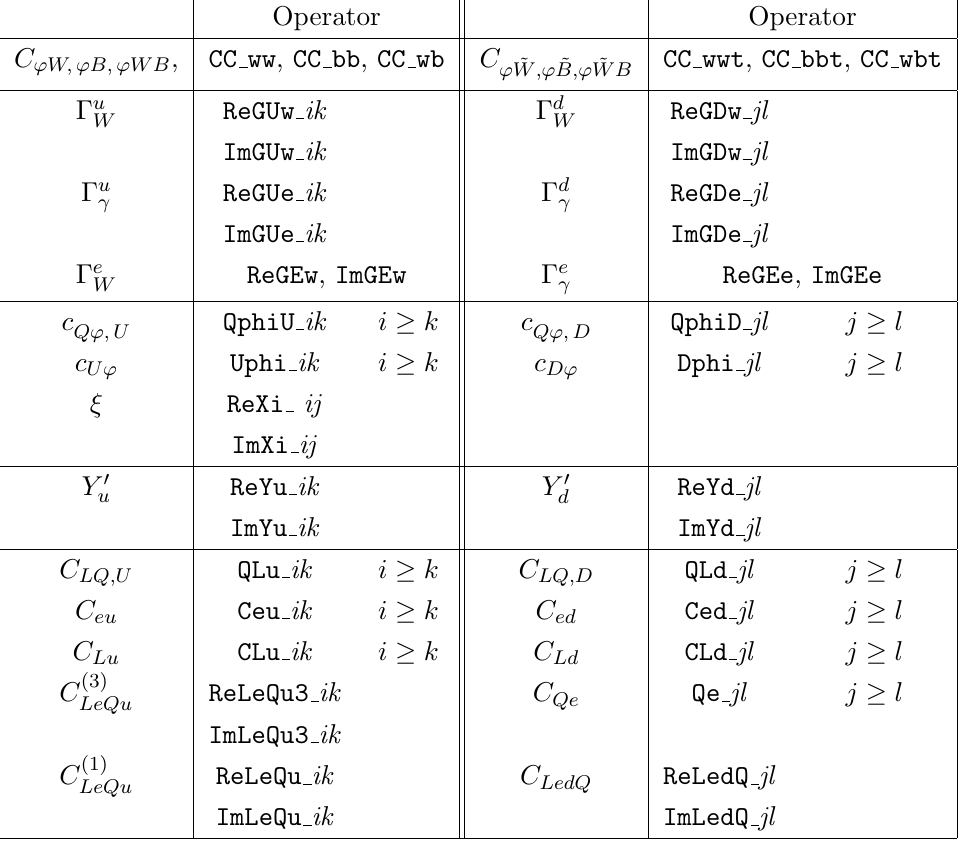
Table 1 . Notation for the coe(cid:14)cients of the dimension-six operators that can be set in POWHEG .